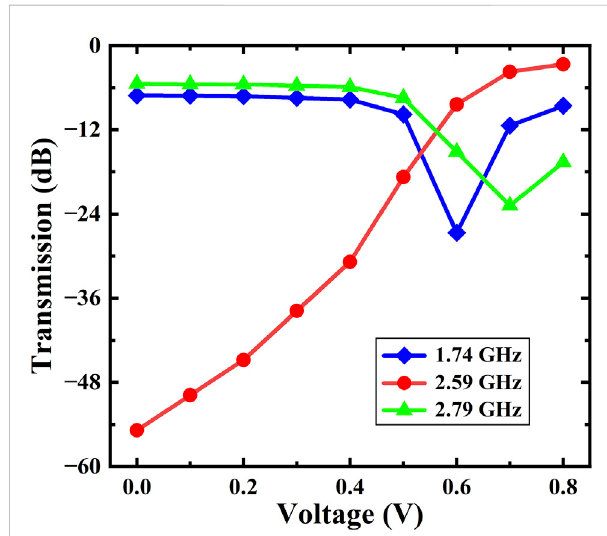
FIGURE 7 Measured transmission versus bias voltage at three characteristic frequencies of 1.74 GHz, 2.59 GHz, and 2.79 GHz,